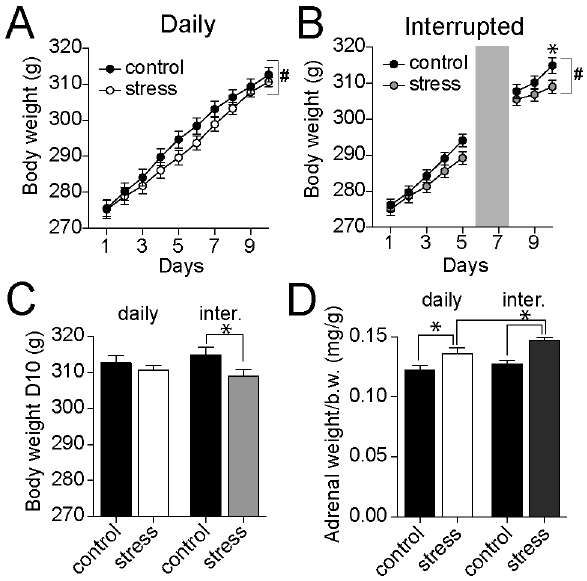
Figure 2. Interrupted stress has greater impact on body weight and adrenal gland weight. A) Weight gain over time in the daily stress group compared to the daily control group was measured. There was a significant Day x treatment pattern (2-way repeated measures ANOVA). However, body weight on any individual day was not significantly different between groups in post hoc comparisons after correction for multiple comparisons. B) Interrupted stress led to a transient difference in body weight that recovered during the interruption, but reappeared after the resumption of stress. C) When measured one day after the last stress or control session, daily stress did not have a significant effect on body weight, while interrupted stress significantly decreased body weight. D) Adrenal gland weight was increased by daily or by interrupted stress (normalized to body weight displayed here). The effect of interrupted stress on adrenal gland weight was significantly greater than daily stress. * indicates p , 0.05 in post hoc tests after significance in a two-way repeated measured ANOVA (B) or two-way ANOVA (C, D). # indicates significant Pattern x Day interaction in a two-way